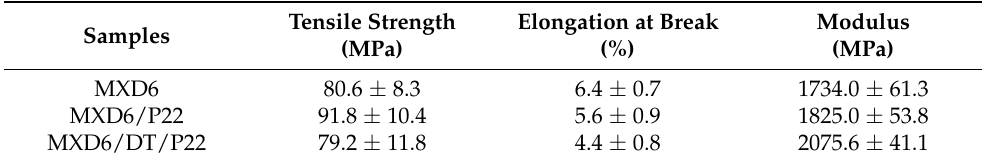
Table 6. The mechanical properties of neat and modified